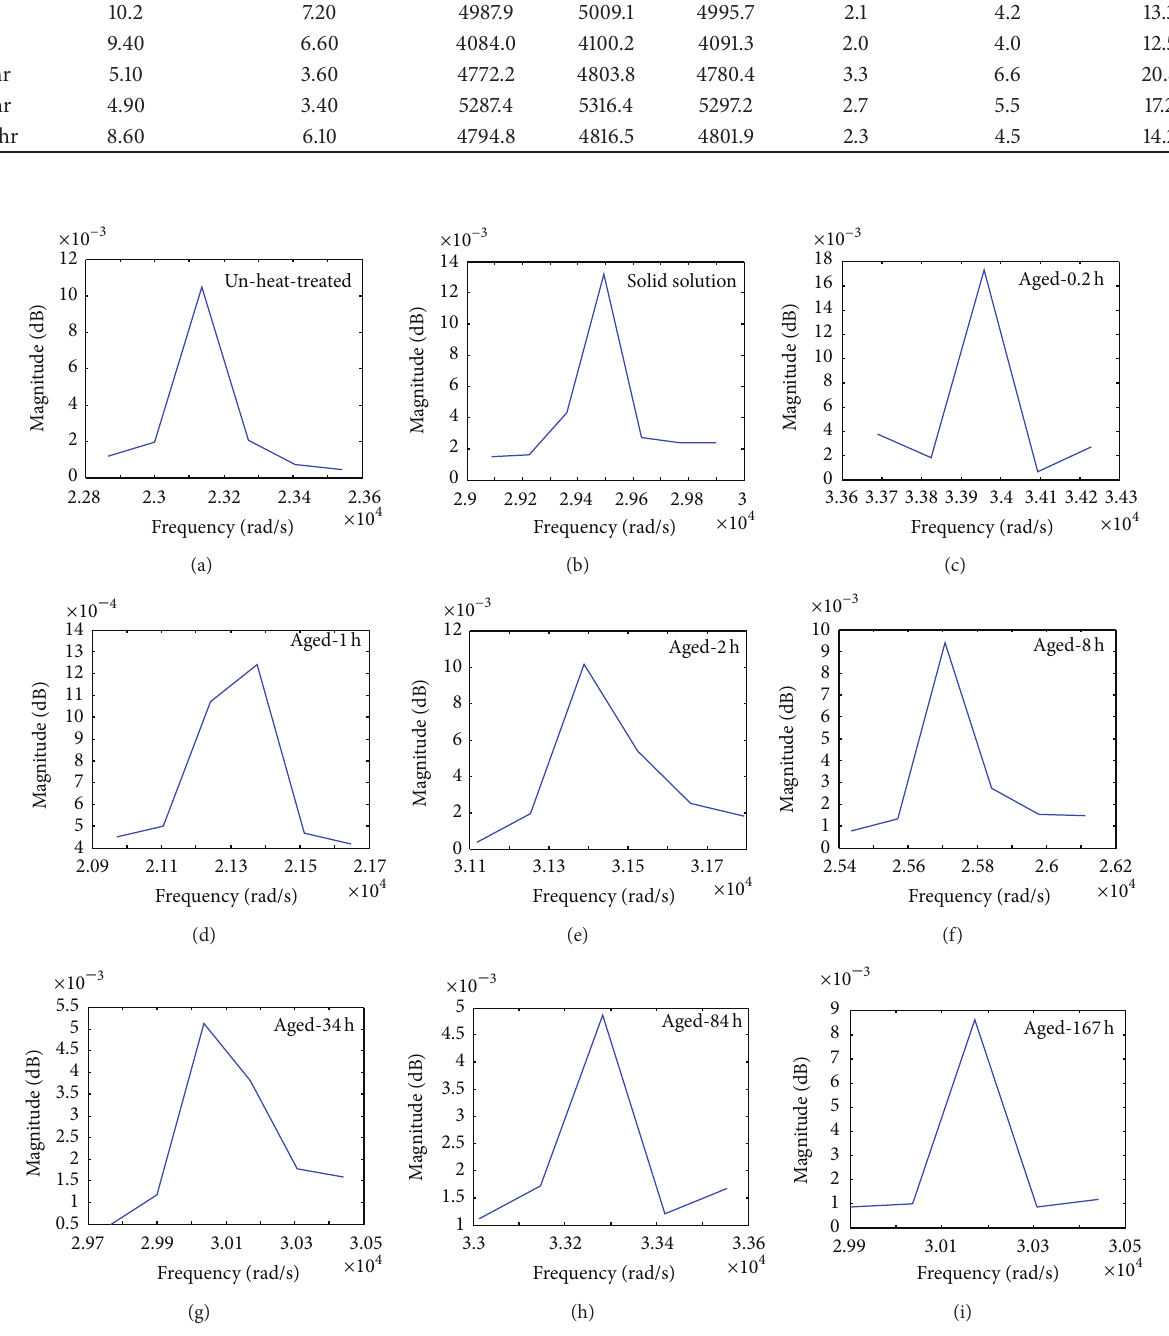
Figure 4: Frequency response variation as a function of frequency transformation using MatLab